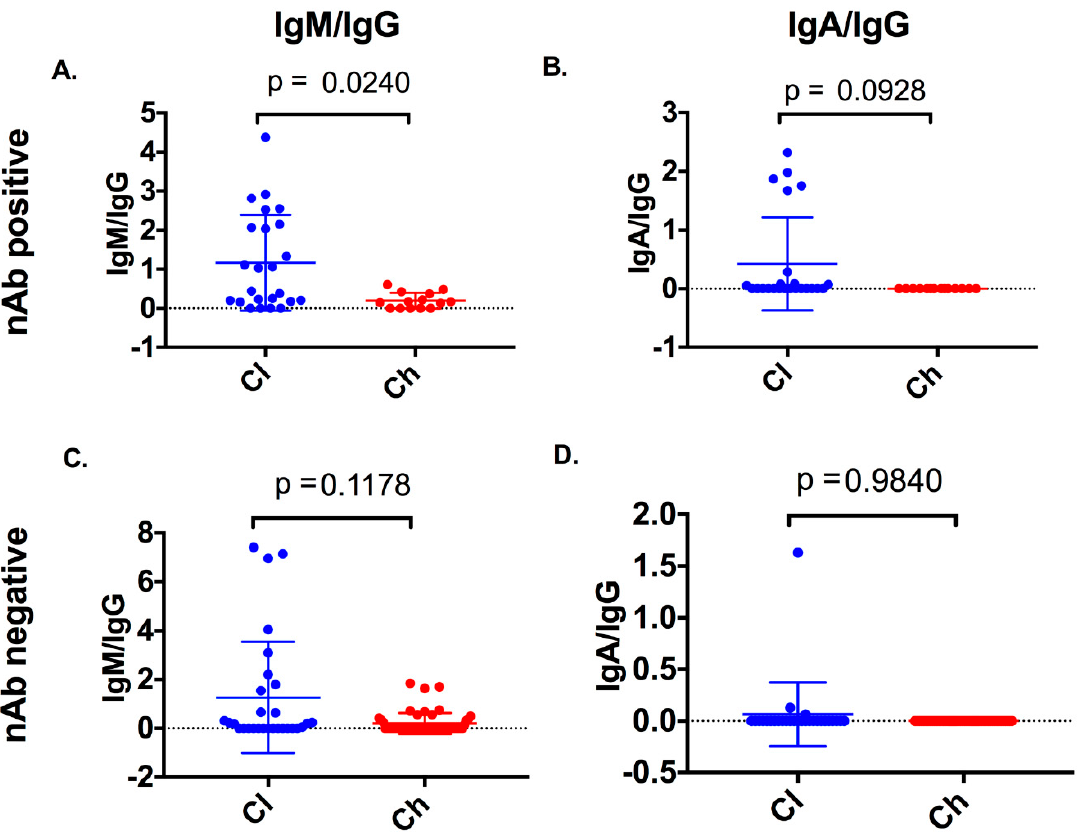
Figure 7. Anti-E2 isotype ratios were compared between clearers and chronic progressors at samples with neutralising antibody (nAb) activity and without nAb activity. Anti-E2 IgM/IgG and anti-E2 IgA/IgG was compared between clearers and chronic progressors in samples with nAb activity (nAb- positive, panels ( A , B )) and without nAb activity (nAb-negative, panels ( C , D )).